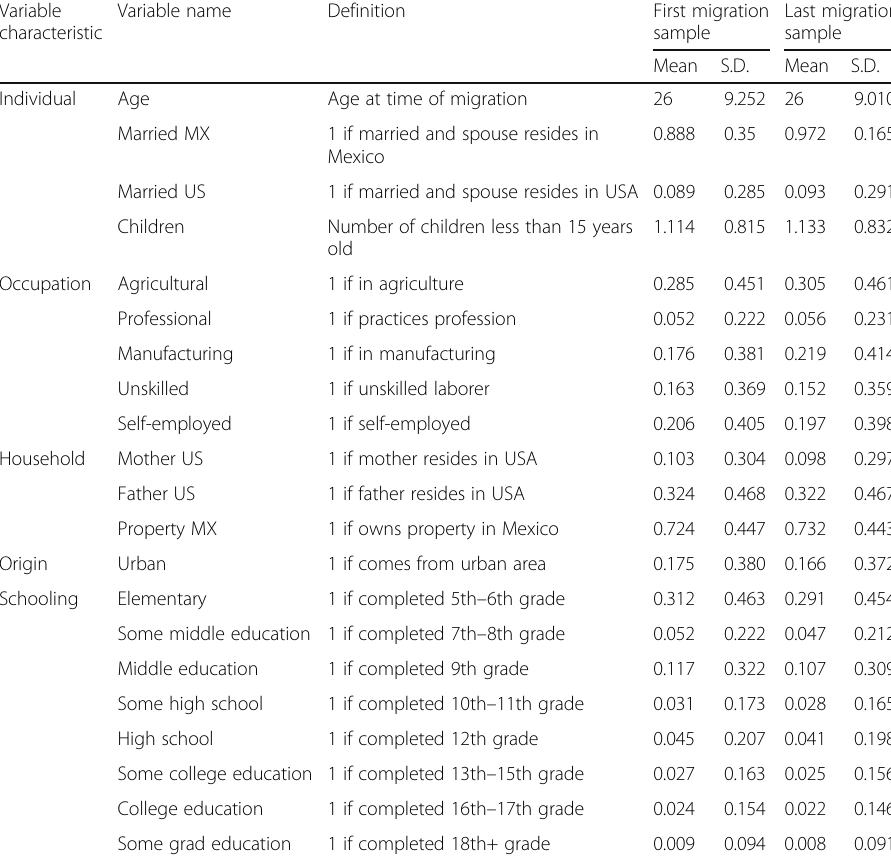
Table 2 Summary